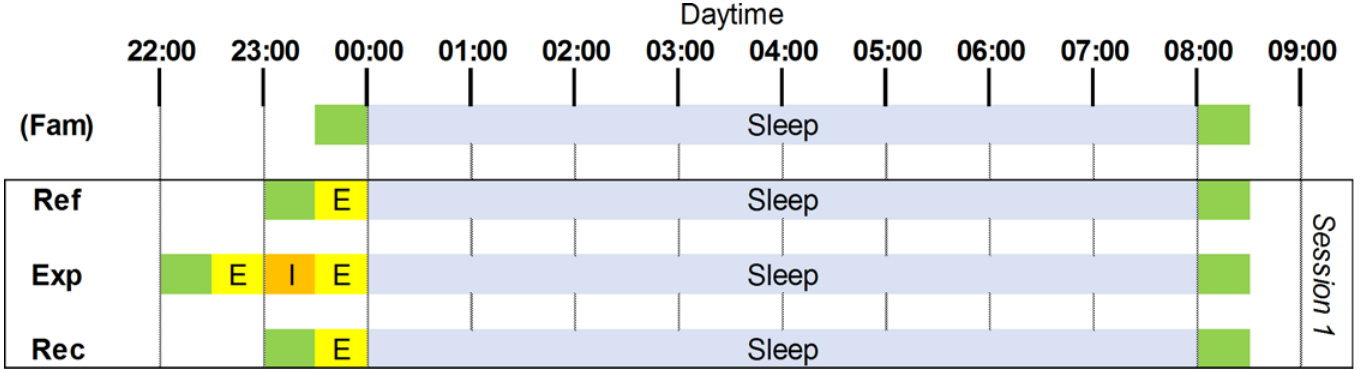
Fig 1. Schematic representation of the experimental protocol for the first four nights. Fam, familiarization night, exclusively before the first session; Ref, Reference night; Exp, Experimental night, during which one of the three movies was presented to the participant; Rec, Recovery night. In green, time to install or remove electrodes; in orange, emotional induction (I); in yellow, evaluation (E) of emotional state with PANAS; in blue, sleep